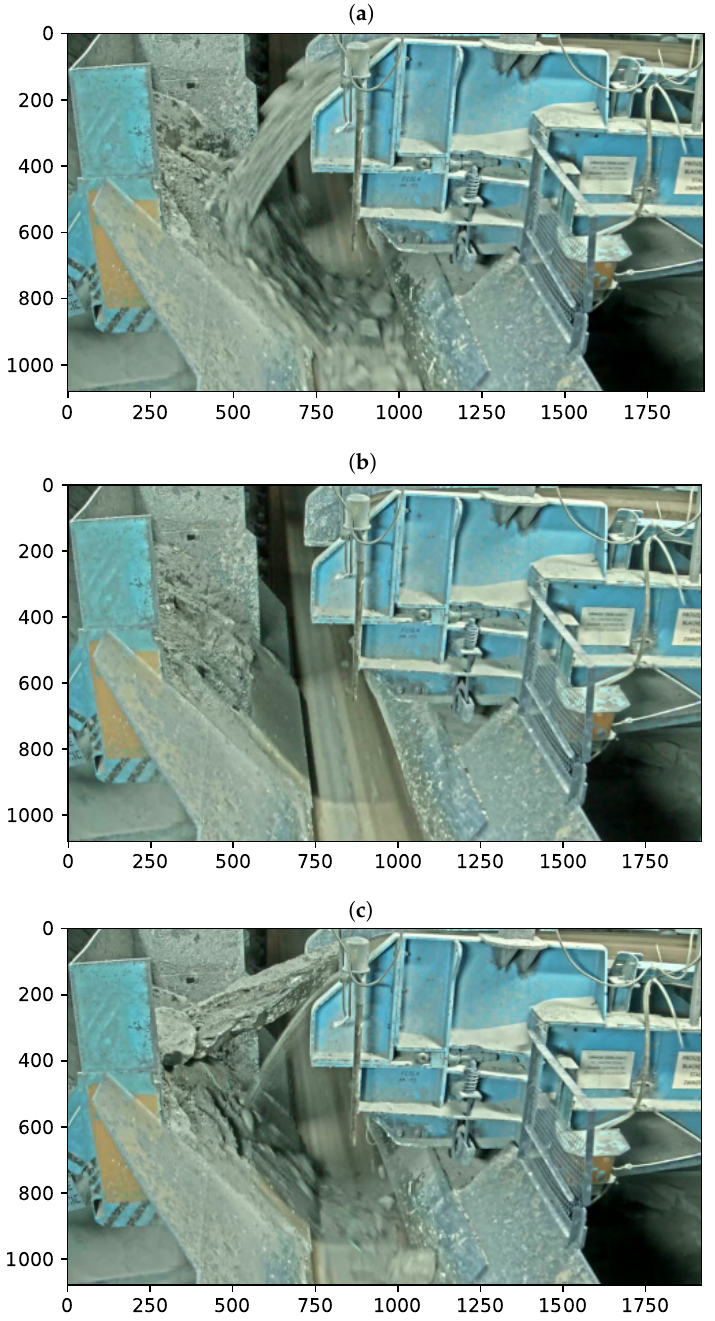
Figure 3. Recorded original data frames: ( a ) normal operation of the transfer point—free flow of bulk material; ( b ) normal operation of the transfer point—no flow; ( c ) anomalous operating state of the transfer